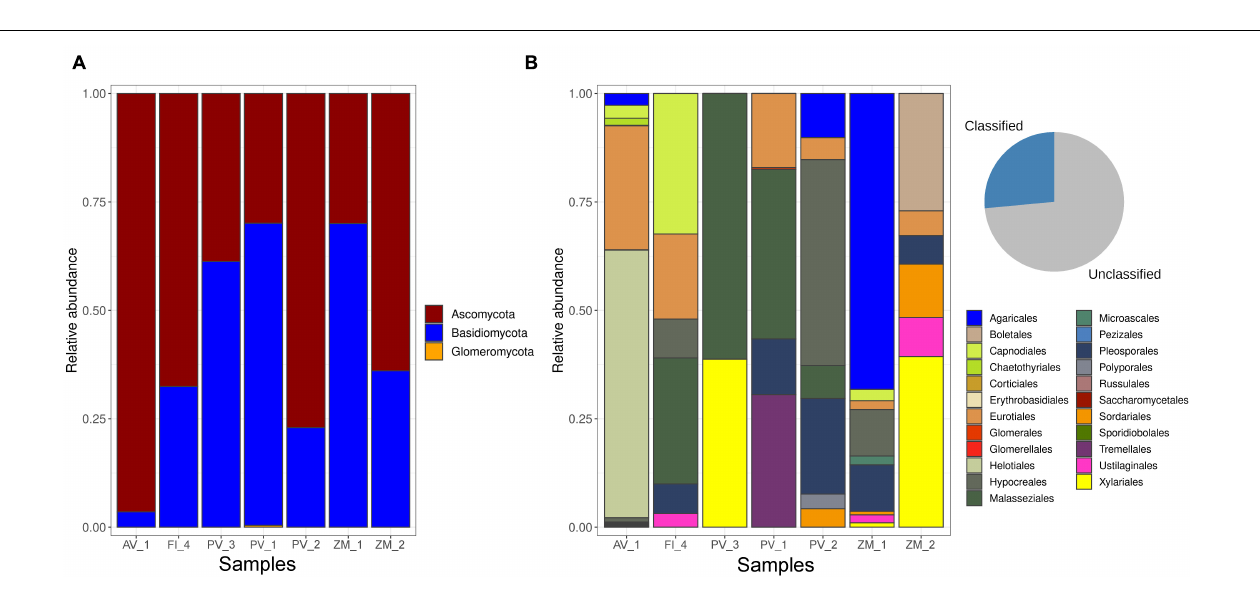
FIGURE 1 | Rarefaction and extrapolation curves of fungal amplicon sequence variants (ASVs) obtained from deep-sea sediment samples collected in the Pescadero Basin (PV_1, PV_2, PV_3), Pescadero Transform Fault (FI_4), Alarcón Rise (AV_1), and Alfonso Basin (ZM_1, ZM_2).